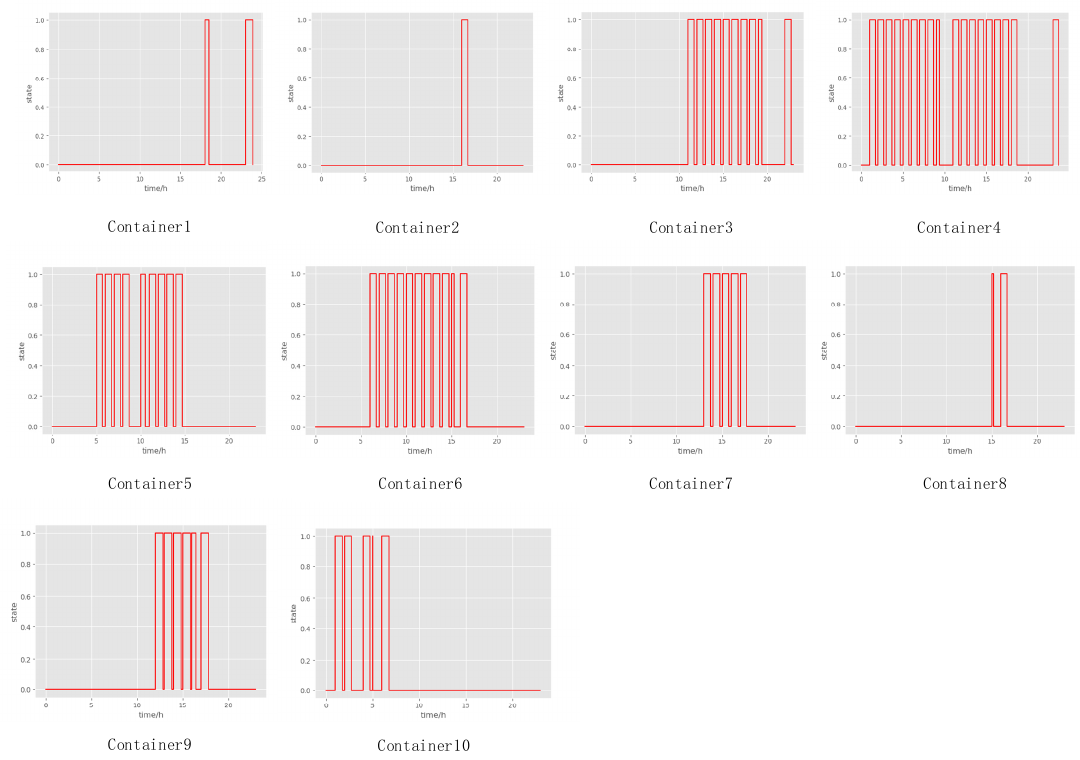
Figure 9. ON/OFF control strategy of containers with day-ahead optimization and control.